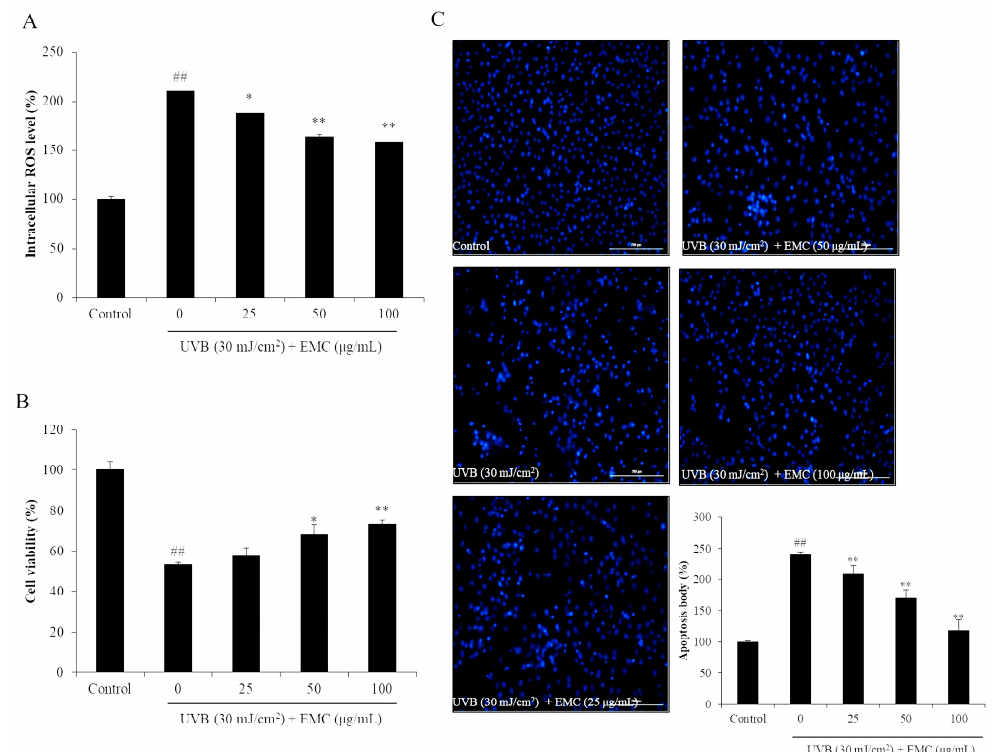
Figure 5. EMC protects HaCaT cells against UVB-induced photodamage. ( A ) Intracellular ROS Figure 5 scavenging e ff ect of EMC in UVB-irradiated HaCaT cells; ( B ) protective e ff ect of ECM against UVB-induced cell death; ( C ) protective e ff ect of EMC against UVB-induced apoptosis. The